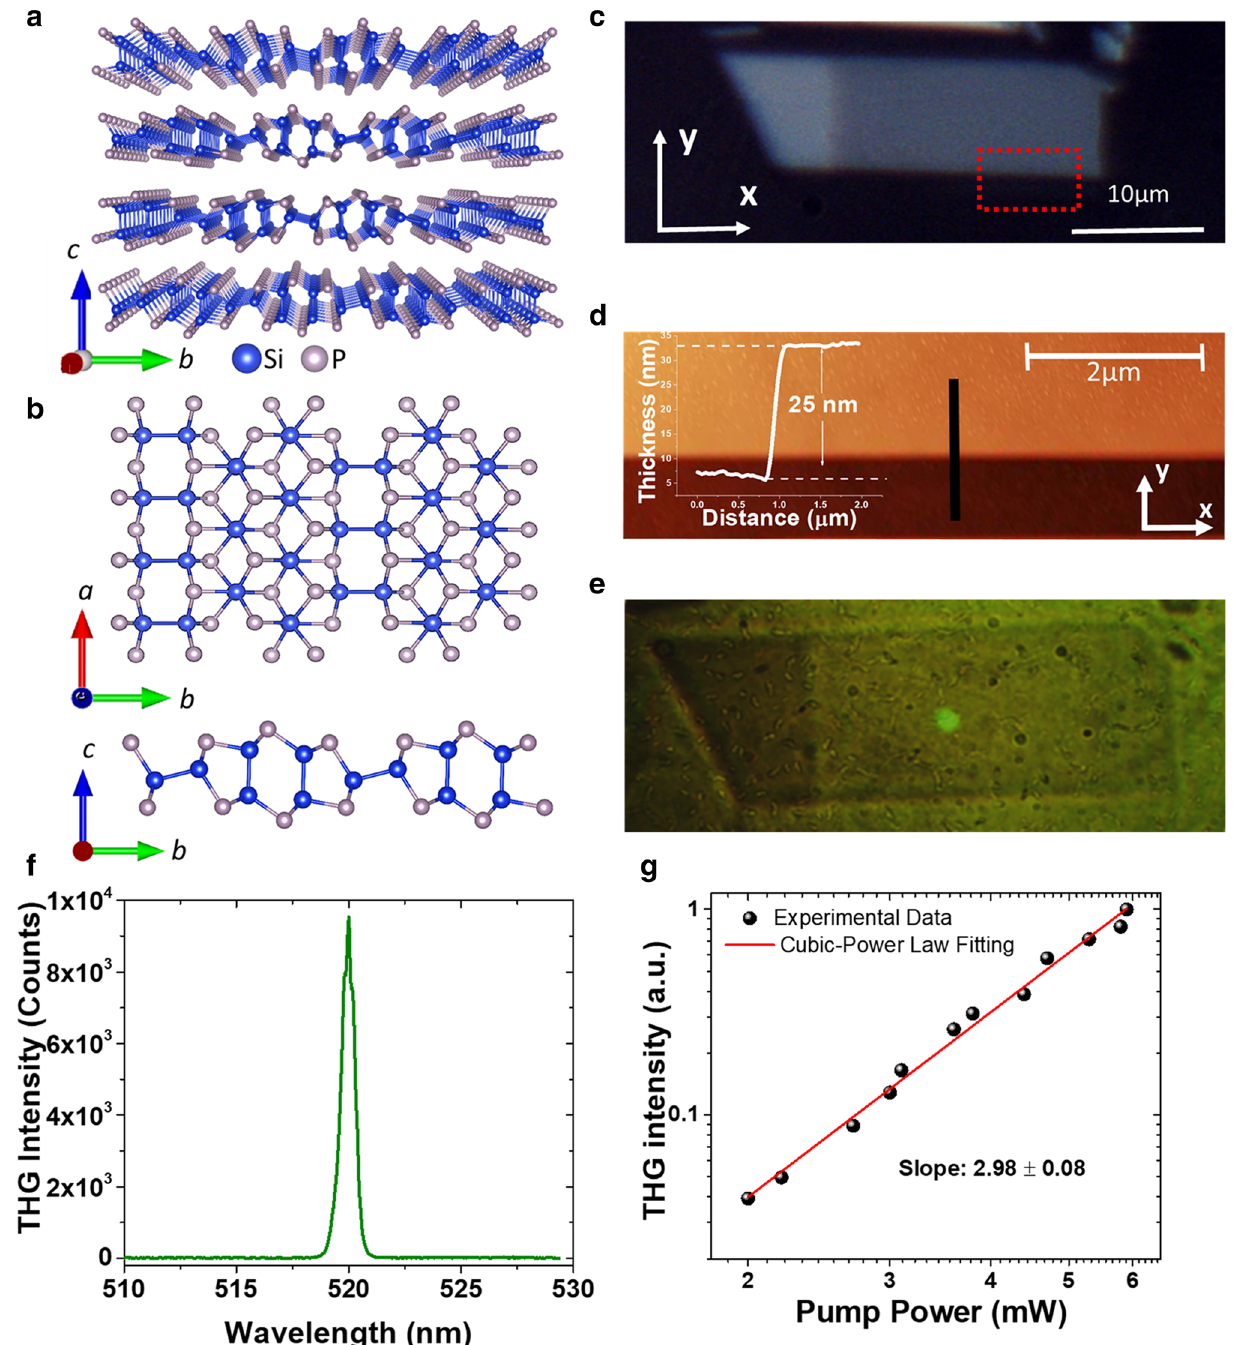
Figure 1. (a) The perspective view schematic of the crystal structure of 2D SiP. (b) The top view and side view schematics of a SiP monolayer. (c) The optical reflection microscope image of one exfoliated SiP flake with the laboratory axes x and y . Scale bar is 10 μm. The red dashed rectangle represents the region that the AFM is measured. (d) The AFM image of the SiP flake with the height profile through the black line as the inset figure. Scale bar is 2 μm. (e) The optical transmission microscope image of the flake with the green THG emission spot. (f) The spectrum of THG emission with the emission wavelength of 520 nm by using the 1560 nm pulsed laser excitation. (g) The measured THG emission intensity as a function of the incident pump power (black spheres) with the cubic-power law fitting curve (solid red